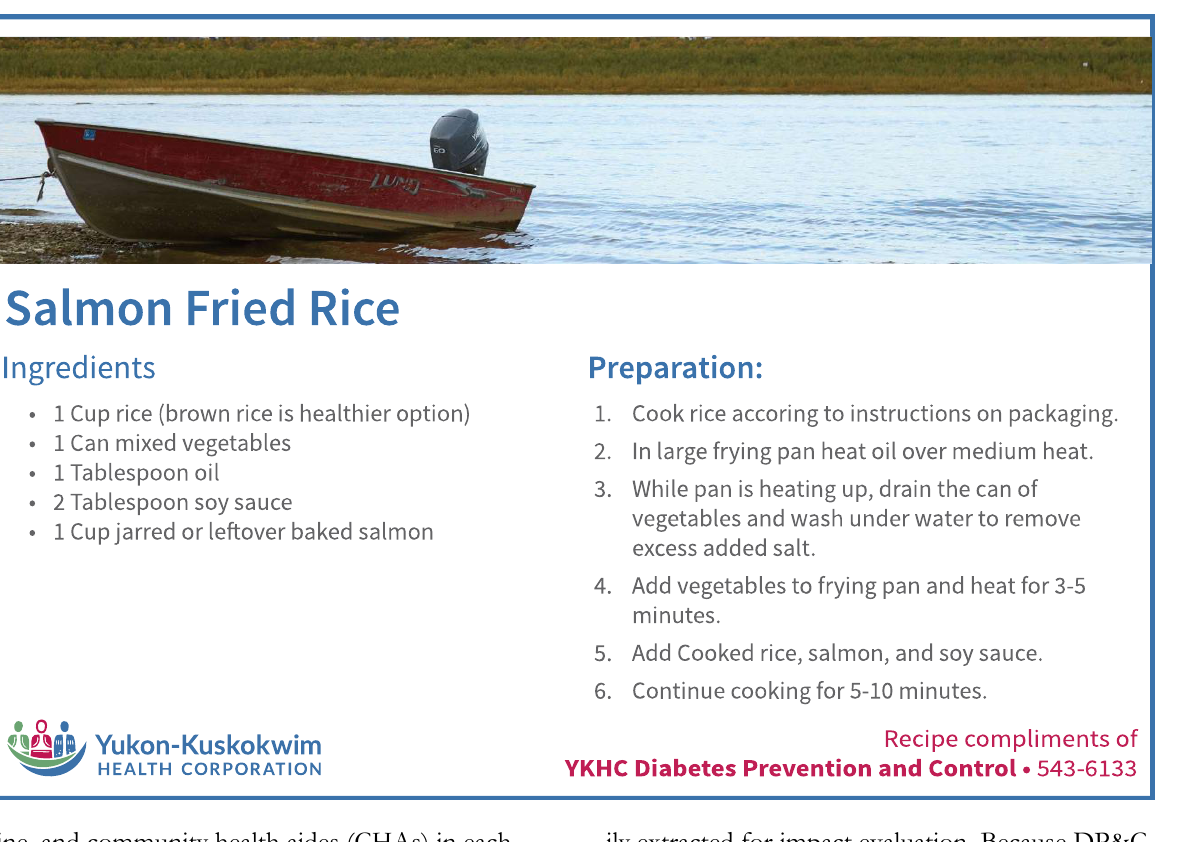
Figure 3. Salmon Fried Rice Recipe